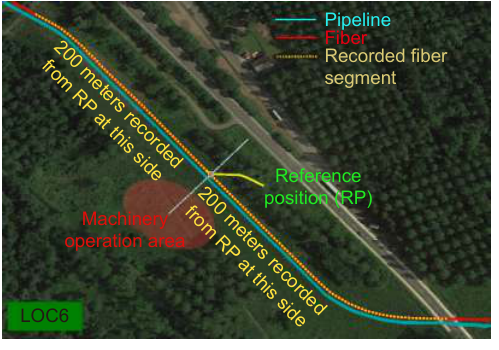
Fig. 7 | Experimental site layout. Figure reproduced from ref. 103 ,